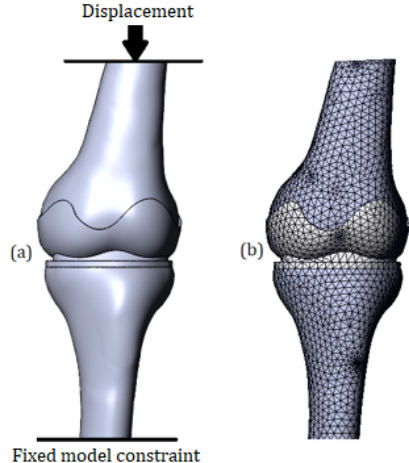
Figure 5. ( a ) Load schematization; ( b ) Finite element model.